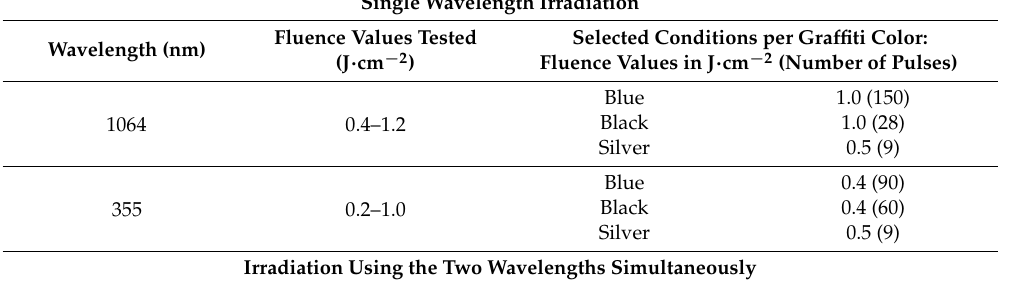
Table 2. Irradiation conditions for the extraction of blue, black, and silver graffiti paints from the Vilach á n